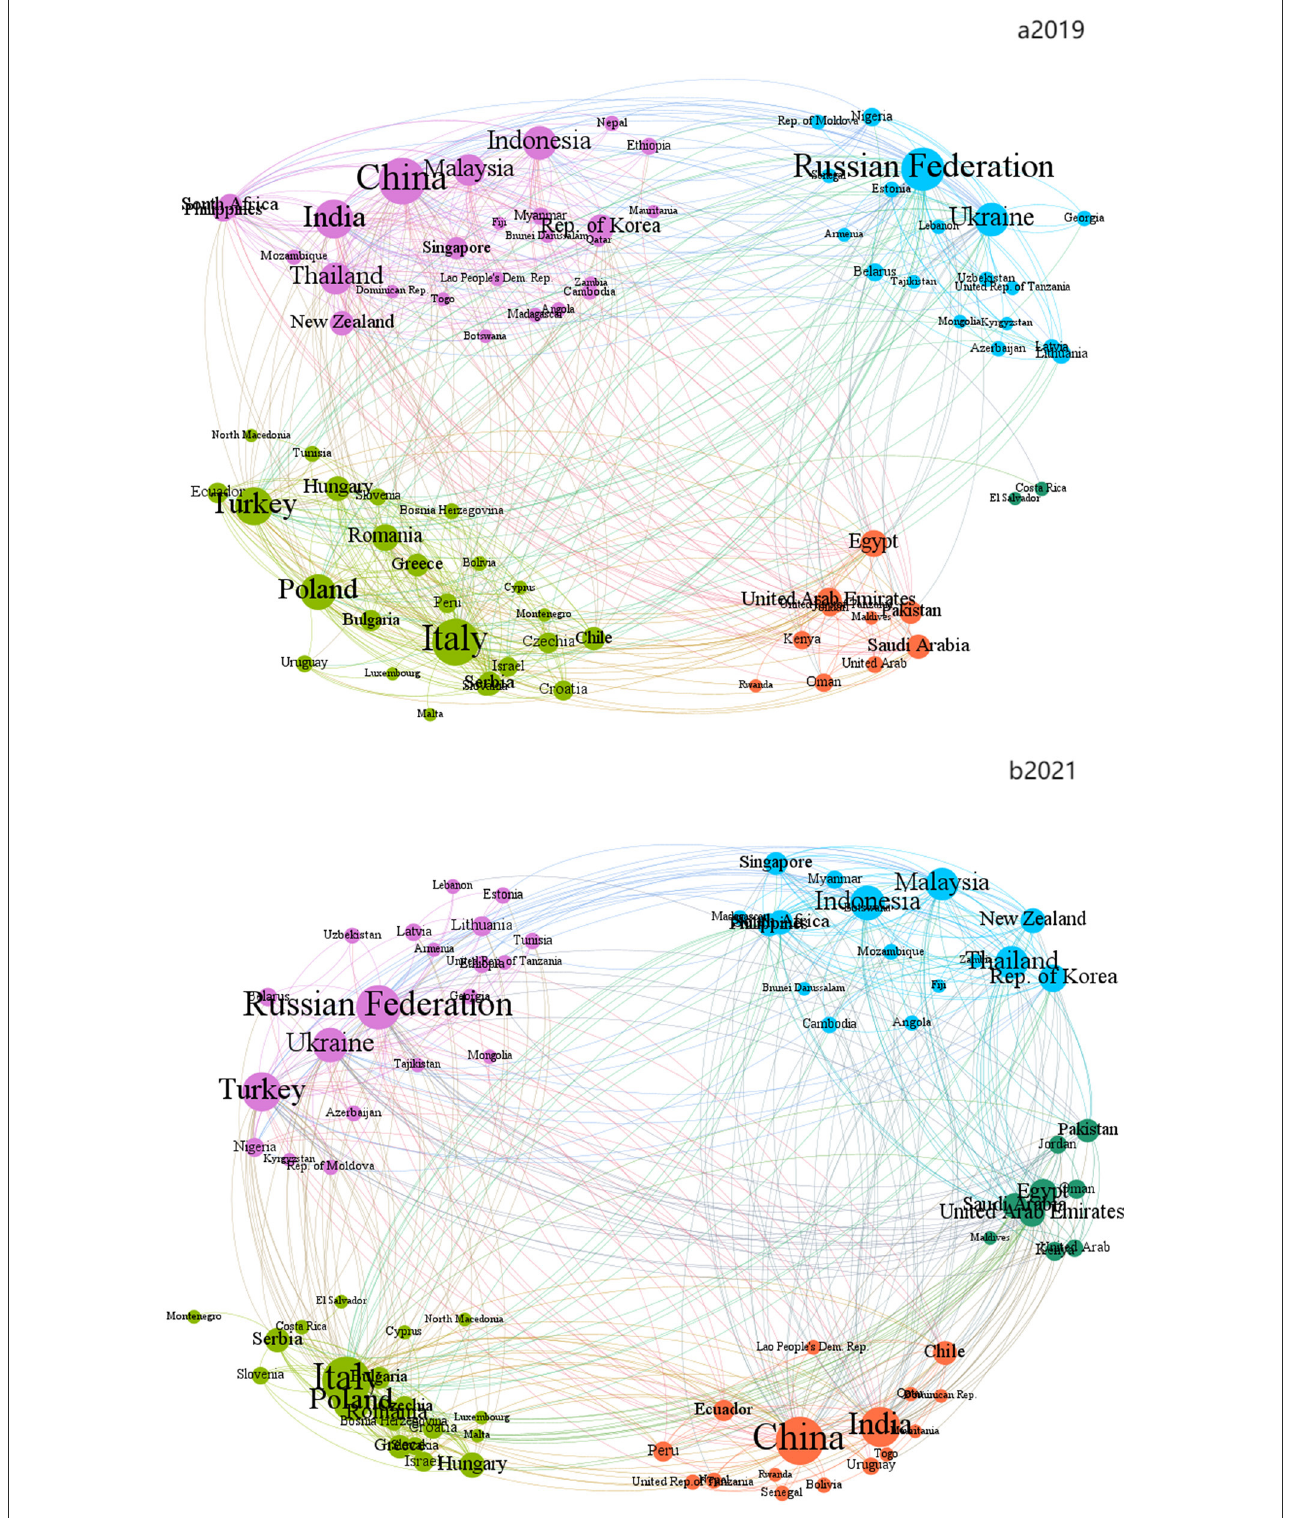
FIGURE4 Community structure and flow patterns in the agricultural product. The same color indicates the same trade community. The thicker and larger the line and dot, the more scale of export quantity.